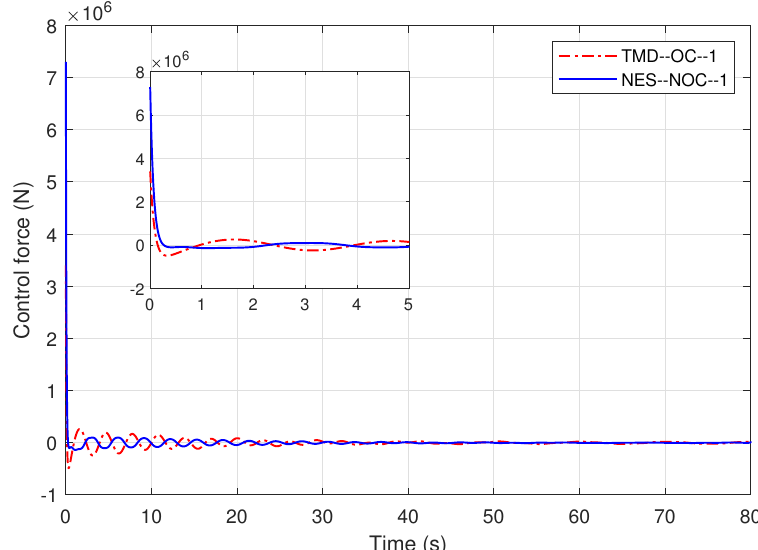
Figure 15. Control force by TMD–OC–1 and NES–NOC–1.